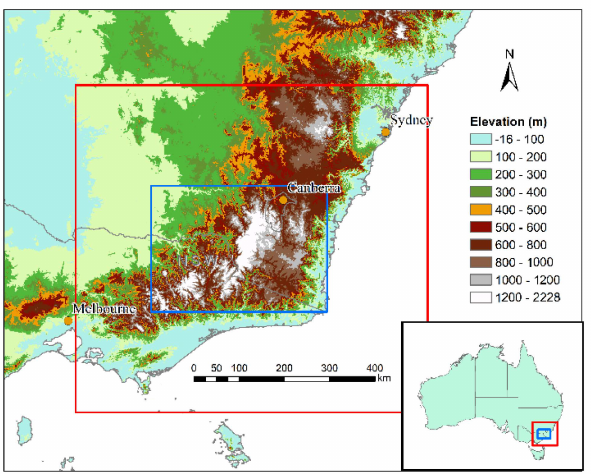
Figure 1. Locations of Australian Alps. The blue rectangle area is the domain to analyse differences between high and low elevations. The red rectangle area denotes the domain to show spatial distribution of future changes in temperature and its